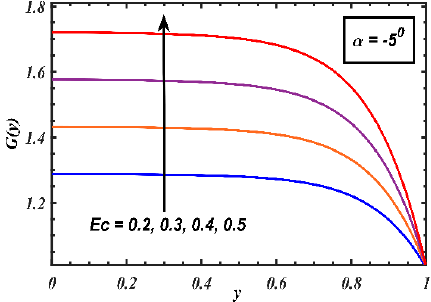
Figure 9. Variation of G(y) in converging for Ec = 0.2, 0.3, 0.4, 0.5 and = − =